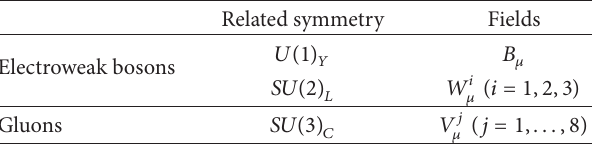
Table 1: The gauge field content of the